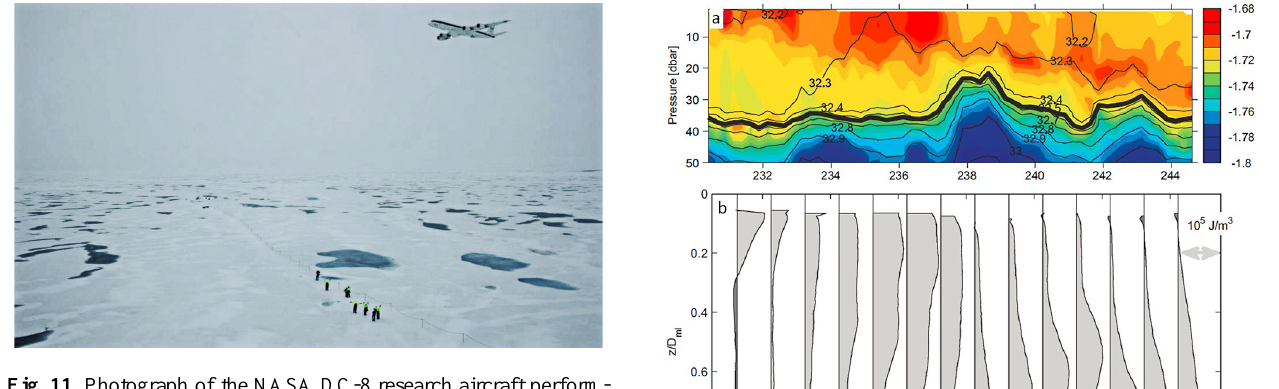
Fig. 11. Photograph of the NASA DC-8 research aircraft perform- ing a flyby during its 12 August AMISA mission.